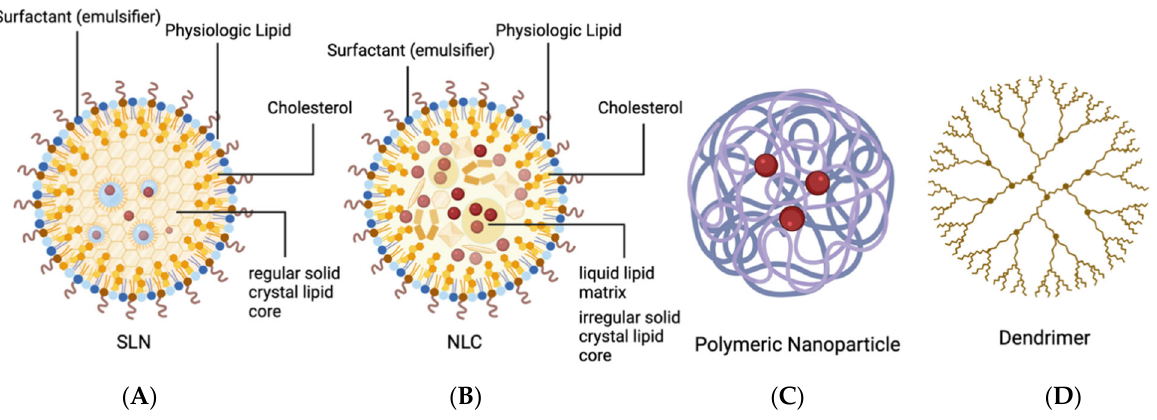
Figure 3. The structure of organic nanoparticles (NPs). ( A ) Solid lipid nanoparticles (SLNs) range from 50 to 1000 nm and consist of a solid crystal lipid core that is stabilized by surfactant, which acts as an emulsifier. Rather than a simple phospholipid bilayer, the exterior of an SLN feature a bilayer of physiologic lipids, such as triglycerides and cholesterol. ( B ) Nanostructured lipid carriers (NLCs) range from 30 to 100 nm in size and have a similar outer layer to SLNs and contain a surfactant that acts as an emulsifier, but they utilize an irregular solid lipid crystal matrix and a liquid lipid (oil) core. ( C ) Polymeric nanoparticles range from 1 to 1000 nm. They utilize a polymetric core that can be loaded with active compounds to produce countless variations of the nanoparticle. ( D ) Dendrimers are organic polymers, which consist of a central core from which ‘branches’ extend outwards to form a spherical shape. They range from 1 to 10 nm in